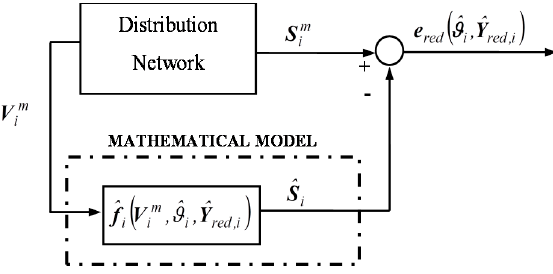
Figure 1. Block diagram of the proposed fitting error.